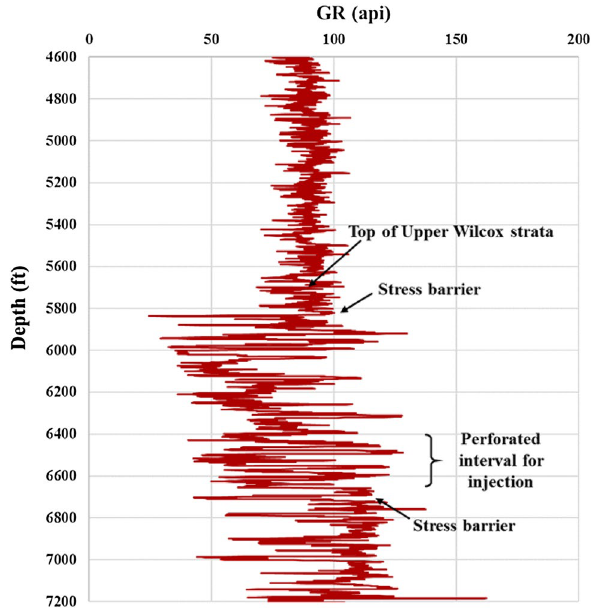
Fig. 5 Interval selected for injection. Gamma ray log was collected from Reed SWD